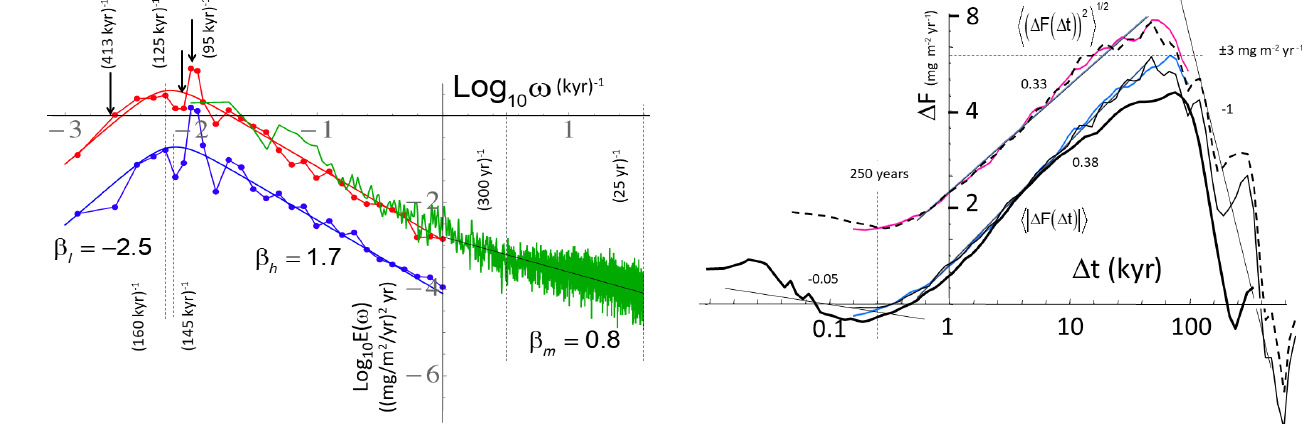
Figure 5. The Haar fluctuation analysis of the entire 800kyr dust flux dataset (thin lines). The dashed black and solid pink lines (top pair) represent rms fluctuations for dimensional and non- dimensional time respectively. The solid black and blue curves are the same but for the mean absolute ( q = 1) fluctuations. The curves with non-dimensional time lags have nominal (average) resolutions of 25years and the fluctuation statistics are averaged over the eight cycles. The thick black line shows the Haar fluctuations for the most recent 400kyr at a 5-year resolution. Note that the peak in the curves occurs as expected at (cid:49)t ≈ 50kyr, i.e. at about a half cycle; the horizontal dashed line shows that at this scale – corresponding to the largest difference in phases – the change in the mean absolute dust flux is about ± 3mgm − 2 yr − 1 . Also shown (dashed vertical line) is the (average) timescale τ c ≈ 250years at which the transi- tion from macroweather to climate occurs. Several reference lines (with the slopes or exponents indicated) are shown showing approx- imate scaling